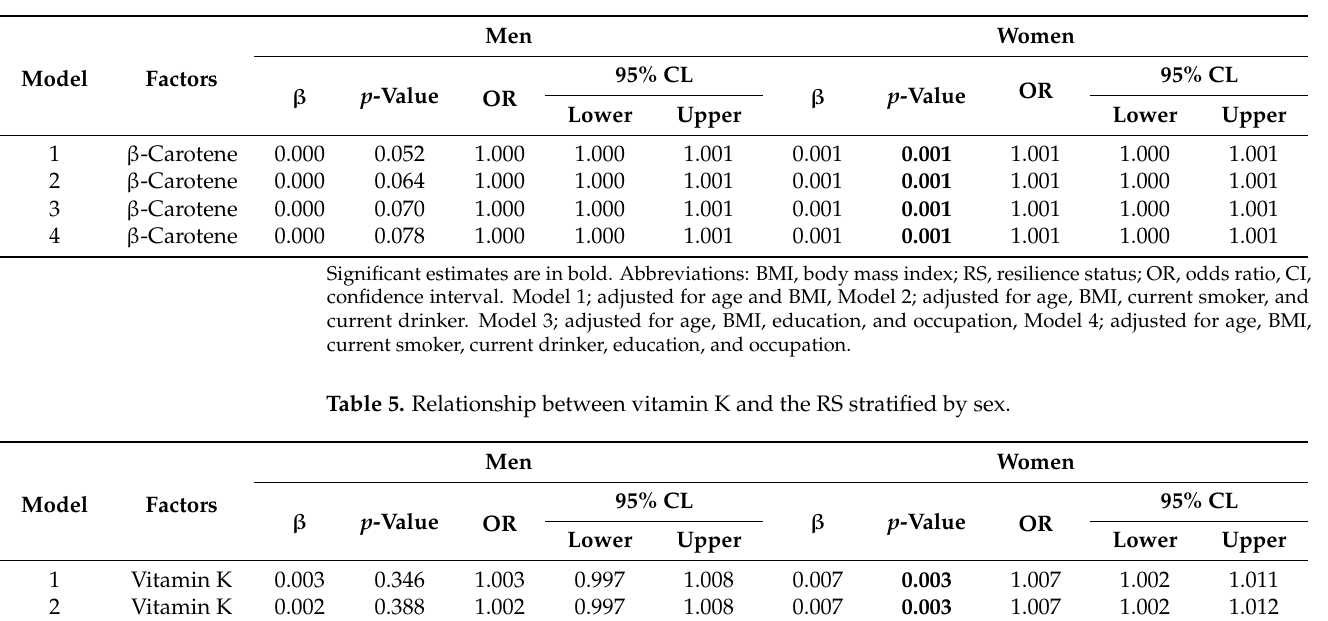
Table 4. Relationship between β -carotene and the RS stratified by sex.